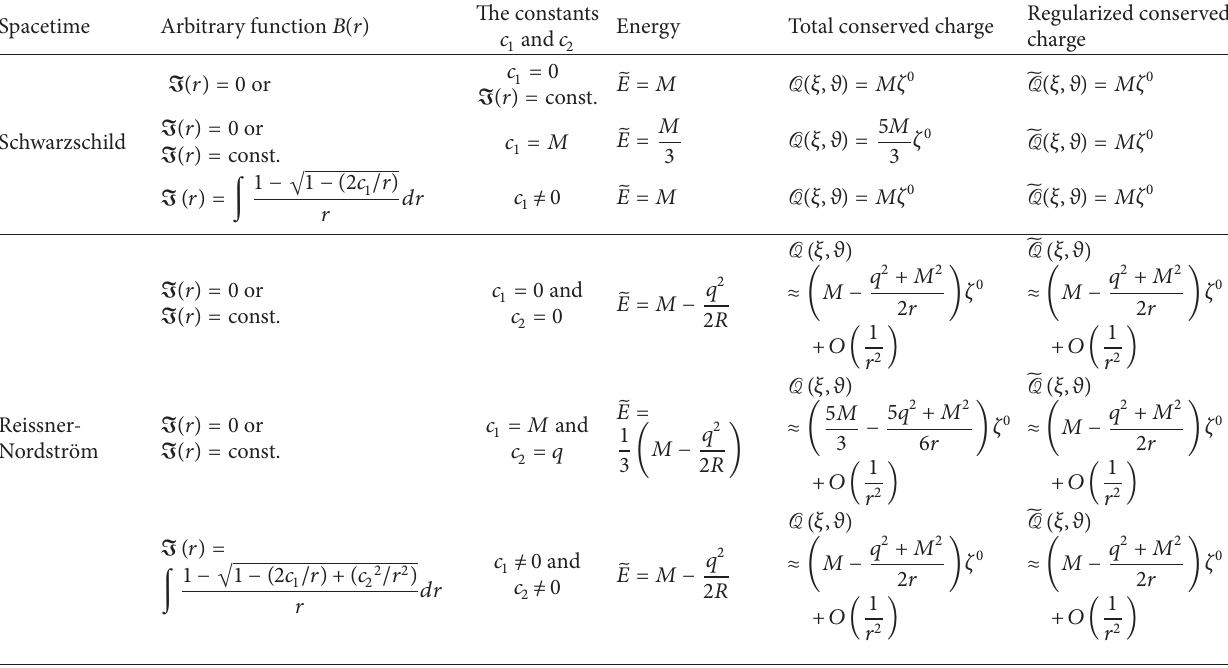
Table 1: Comparison between the results of the arbitrary function I (𝑟) , other constants, and the associated energy. Spacetime Arbitrary function 𝐵(𝑟)